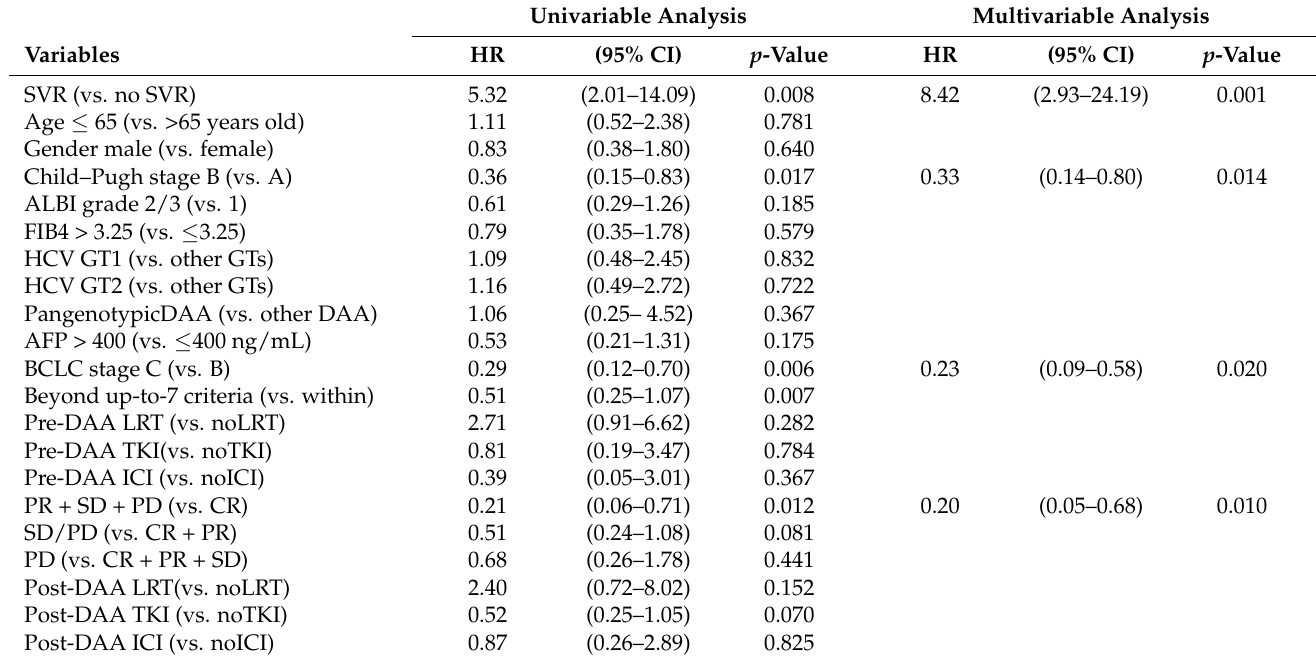
Table 3. The strength of association between overall survival and clinical variables.